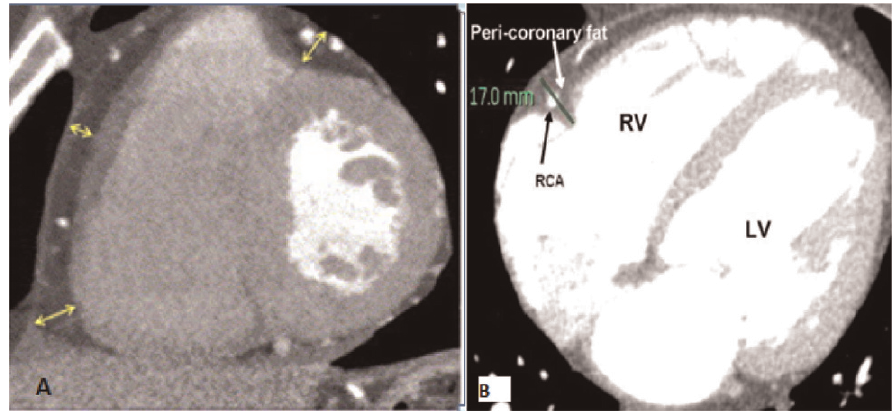
Figure 1 - A) Epicardial fat thickness (yellow arrows). B) Pericoronary fat thickness (green). LV=left ventricle; RCA=right coronary artery; RV=right